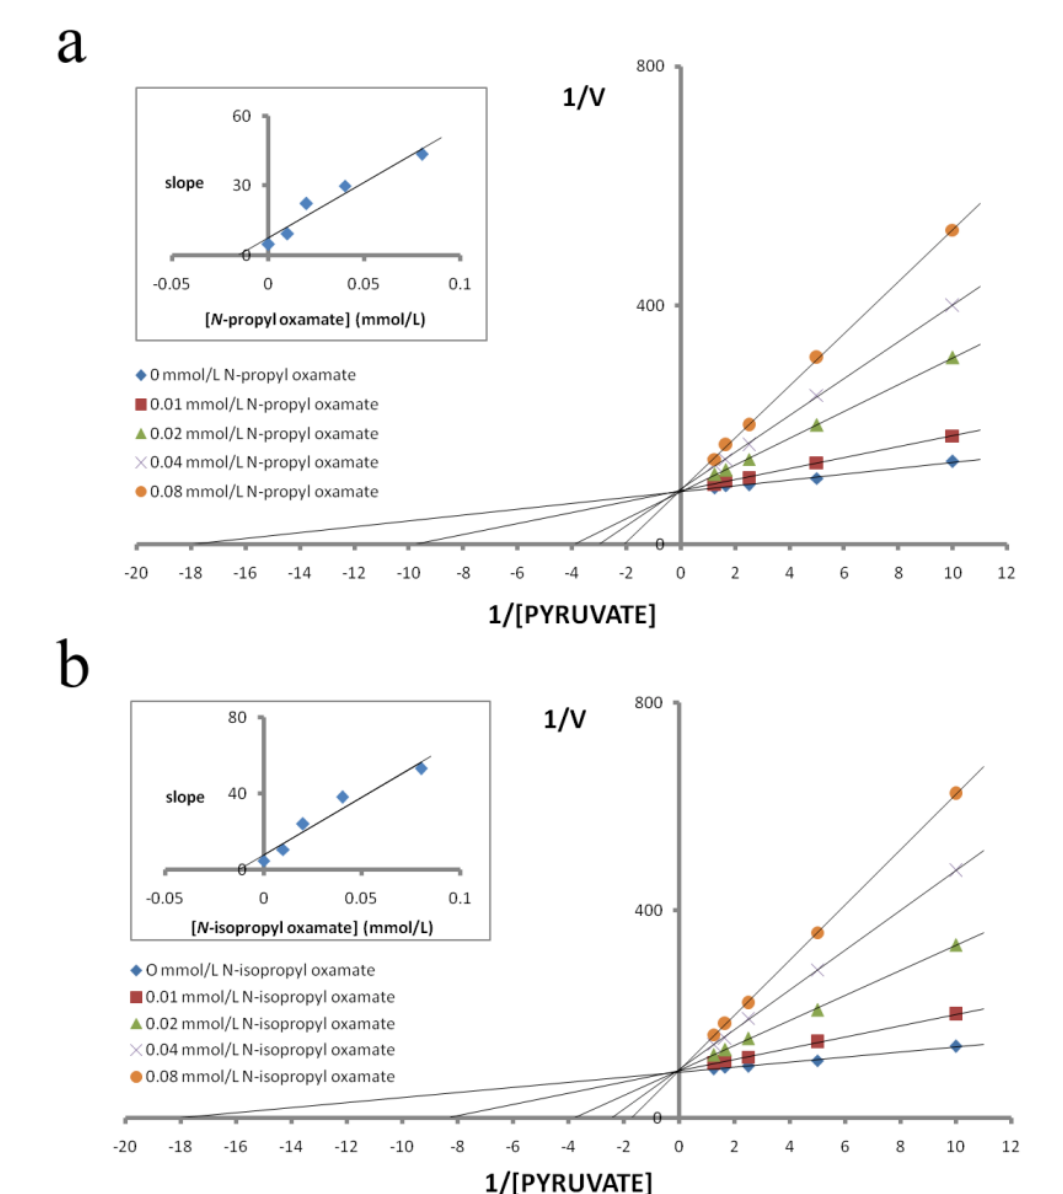
Figure 3. Effect of pyruvate on the inhibitory activity of N- propyl oxamate and N- isopropyl oxamateon plateau pika LDH-C 4 . Reciprocal values of V were calculated taking the reciprocal values of △ 340 nm/min , plots of reciprocal reaction velocity versus reciprocal pyruvate concentration at a constant NADH concentration. The concentrations of pyruvate used were 0.1 mmol/L, 0.2 mmol/L, 0.4 mmol/L, 0.6 mmol/L, and 0.8 mmol/L. NADH concentration was kept at 0.15 mmol/L. The Km of LDH-C 4 for pyruvate was 0.052 mmol/L. ( ◆ )assays with 0 mmol/L, ( ■ ) 0.01 mmol/L, ( ▲ ) 0.02 mmol/L, (×) 0.04 mmol/L and ( ● ) 0.08 mmol/L of (a) N -propyl oxamate or (b) N- isopropyl oxamate. Upper left: determination of Ki from replot of slope values against inhibitor concentrations. The Ki of N- propyl oxamate and N- isopropyl oxamate for LDH-C 4 were 0.015 mmol/L and 0.013 mmol/L,